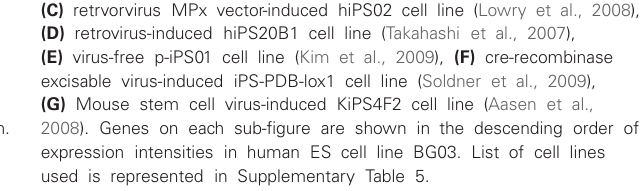
(C) retrvorvirus MPx vector-induced hiPS02 cell line (Lowry et al., 2008), (D) retrovirus-induced hiPS20B1 cell line (Takahashi et al., 2007), (E) virus-free p-iPS01 cell line (Kim et al., 2009), (F) cre-recombinase excisable virus-induced iPS-PDB-lox1 cell line (Soldner et al., 2009), (G) Mouse stem cell virus-induced KiPS4F2 cell line (Aasen et al., 2008). Genes on each sub-figure are shown in the descending order